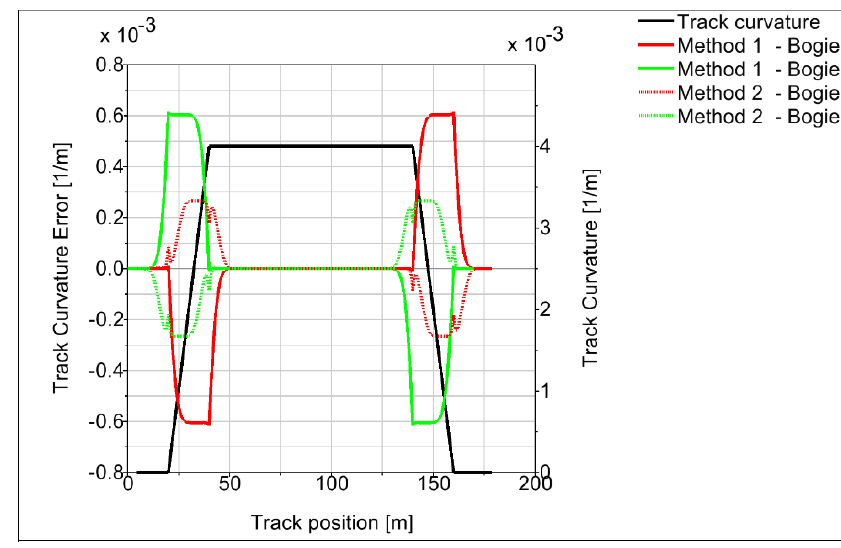
Figure 8. Track curvature estimated by bogie to car body rotation and its derivative. The curvature estimation leg is virtually eliminated, although small overshoots occur around points where the second derivative of track curvature changes. The error of the track curvature estimation for both calculation algorithms is plotted on Figure 9. The algorithm according Equation (2) reduces the track estimation error in the transition track by more than 50% compared to the Equation (1). The track estimation error of Equation (2) in the transition track is less than 7%.